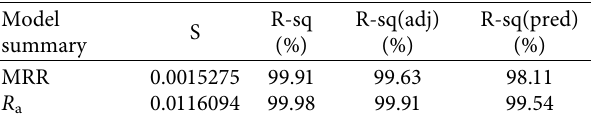
a . Table 7: Model summary for MRR and R a